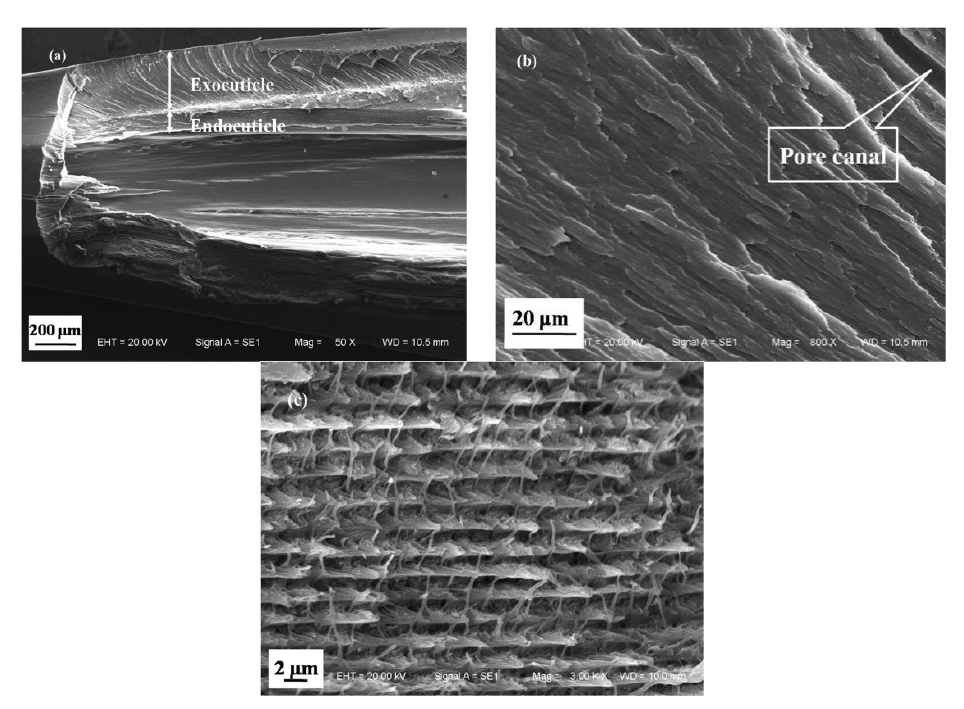
Figure 9. Longitudinal section of the tip of Chinese mitten crab dactylopodite: ( a ) Layered structure at tip of dactylopodite, ( b ) highly condensed structure of exocuticle, ( c ) Bouligand structure in endocuticle.